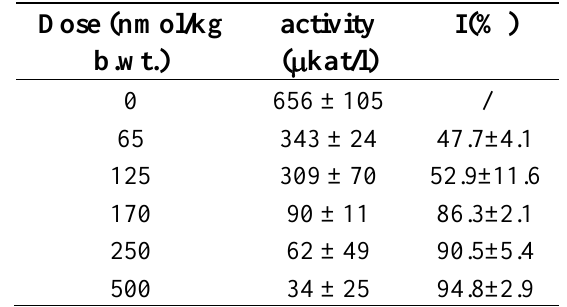
Table 2. Changes in cholinesterase activity after exposition to paraoxon. Letter I indicates percent of cholinesterases